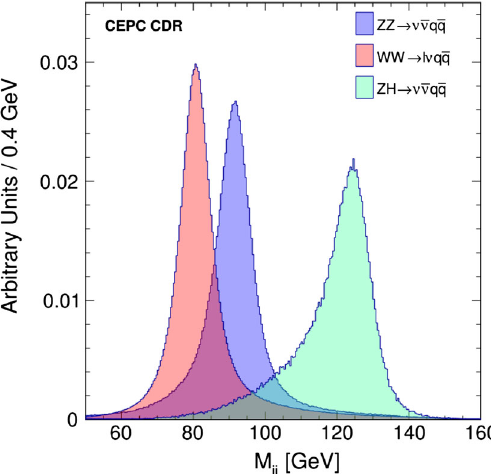
Fig. 13 The distribution of the total invariant mass of the hadronic system of Z Z → νν q ¯ q , Z H → νν( Z ) q ¯ q ( H ) , and WW → μν q ¯ q [1]. The overlapping fraction of WW and ZZ is 47 . 32% ± 0 .